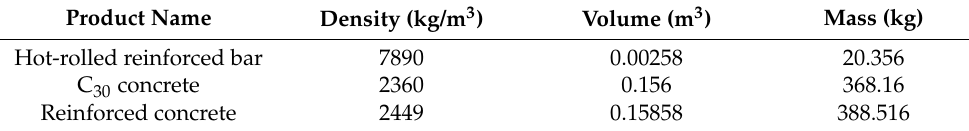
Table 3. Reinforcement characteristics of CG-2 composite beam.